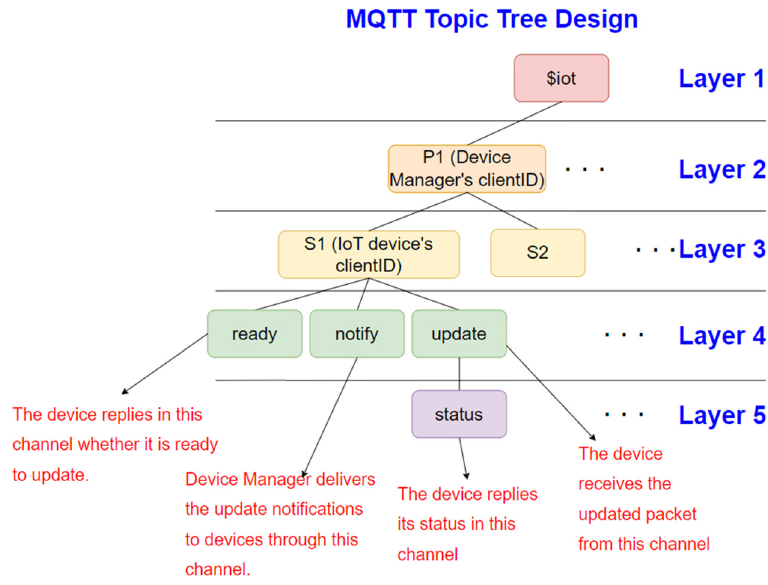
Figure 5. The MQTT topic tree design used in the E2E channel building.